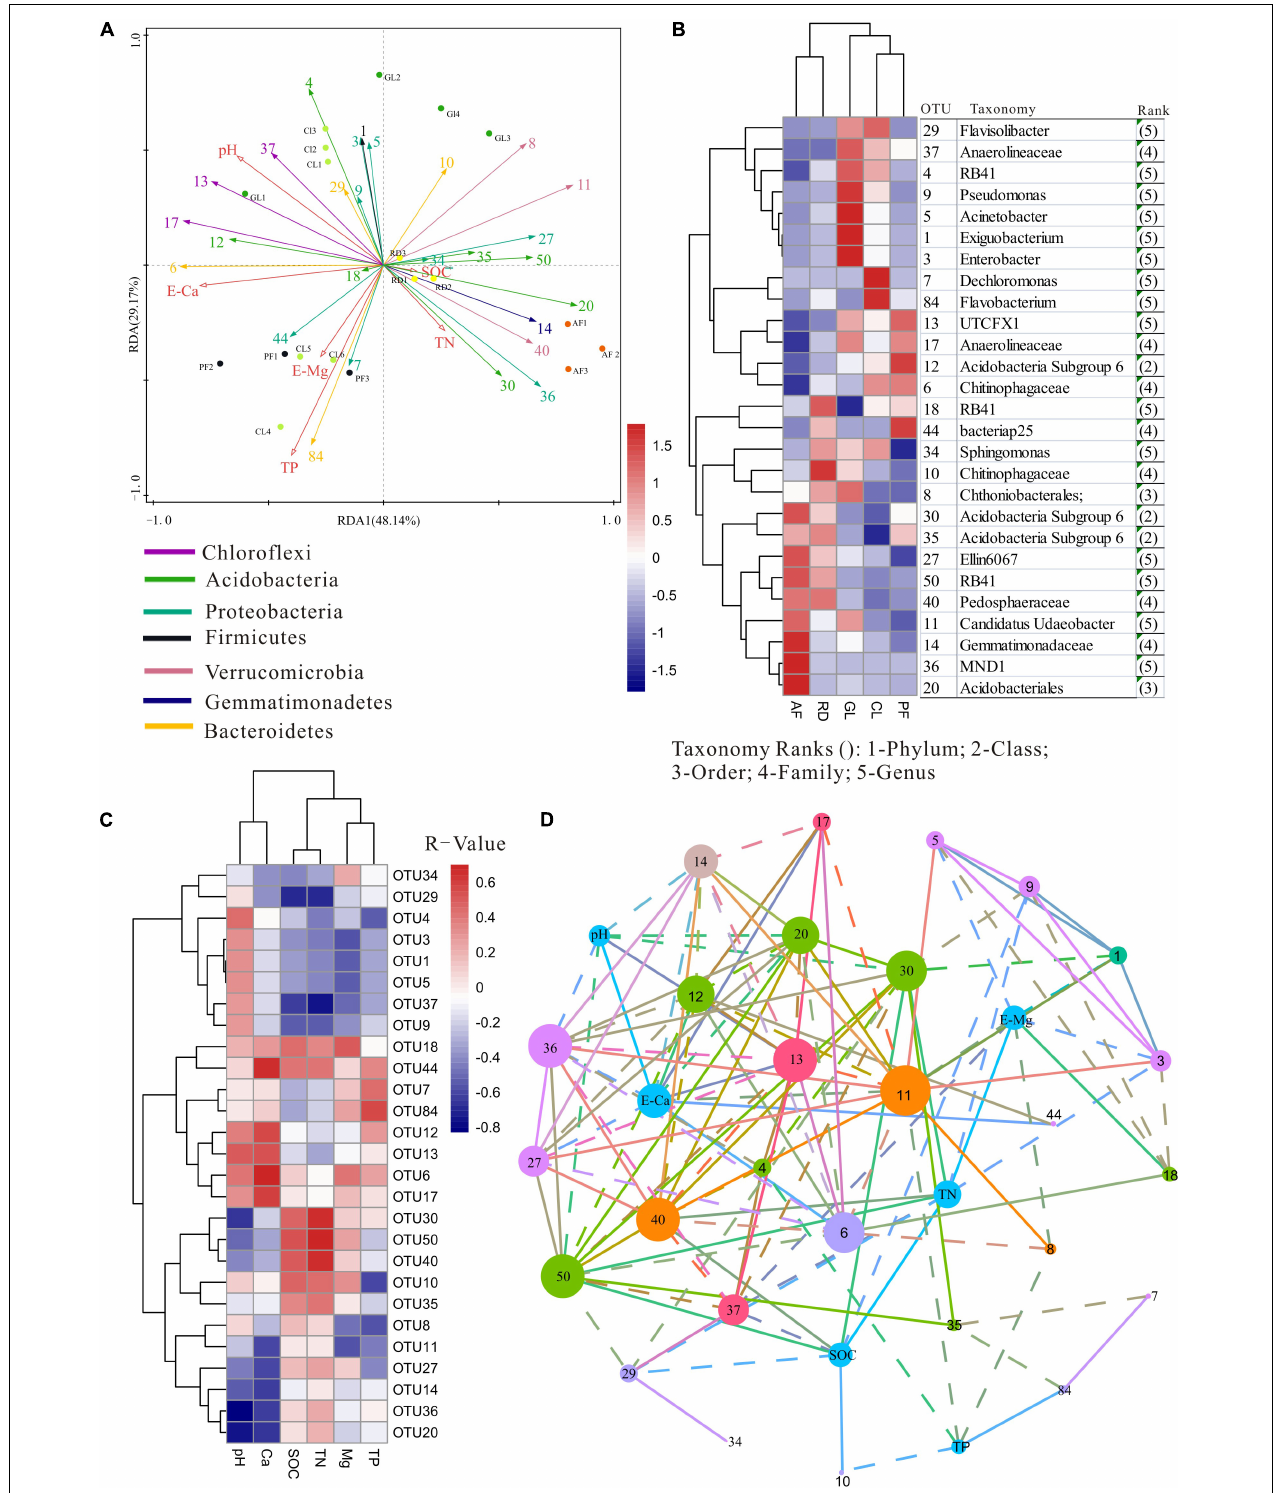
FIGURE 5 | (A) RDA plots showing the relationship between samples (color corresponds to ecological types), 27 top OTUs (color corresponds to taxonomic affiliation) and edaphic variables (red arrows). (B) Heat map illustrating the relative frequency of the 27 most abundant OTUs. (C) Heat map representing clustering between edaphic variables and the 27 top OTUs, which had at least one R -value > 0.5 or < –0.5. (D) Correlation network of significant positive and negative correlations among OTUs (node color corresponds to taxonomic affiliation) and between OTUs and edaphic variables. Node size is proportional to the OTU